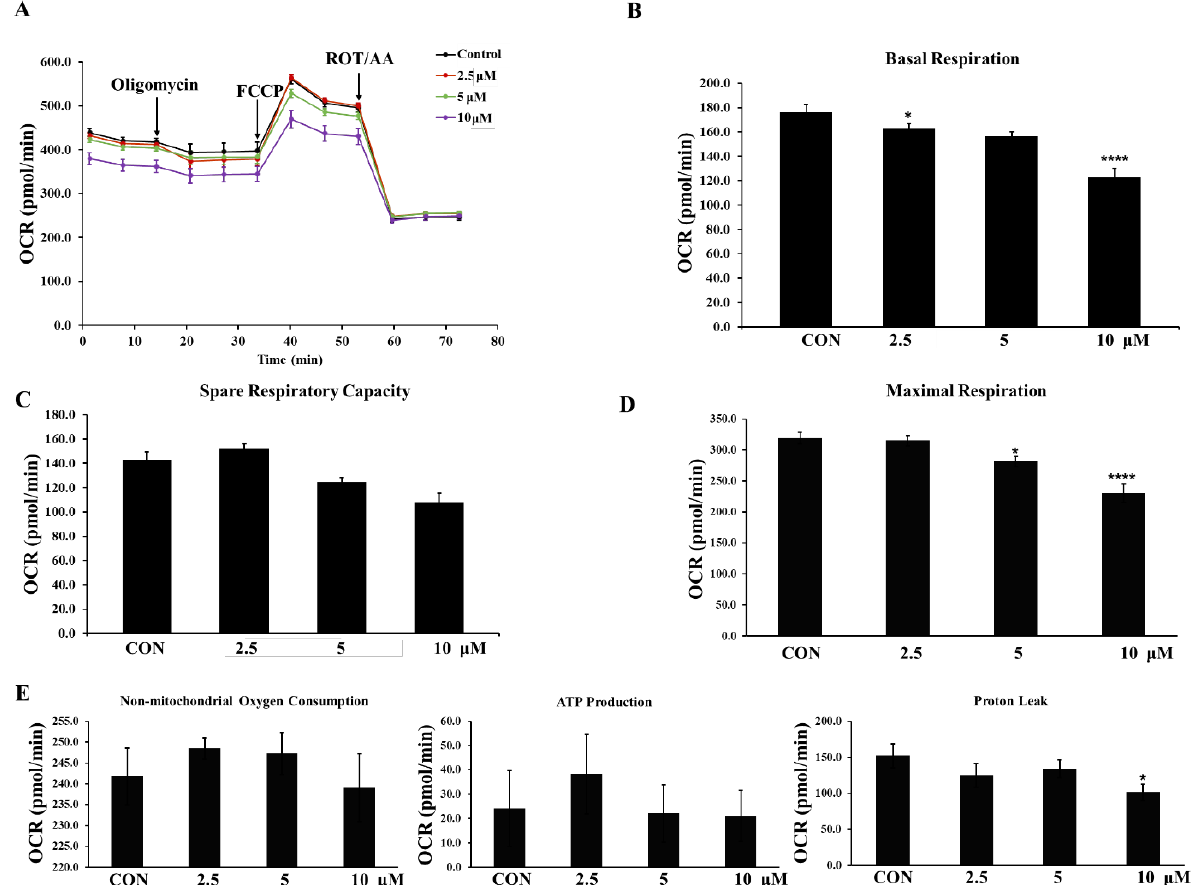
Figure 9. PKM2 specific inhibitor, compound 3h , impairs the mitochondrial activity in LNCaP cells, leading to decreased basal respiration, spare respiratory capacity, and maximal respiration. ( A ) Profile of mito stress test data for oxygen consumption rate (OCR) (pmol/min) in LNCaP cells with arrows indicating injections into media of specific stressors. ( B – E ) Results of Seahorse XFe cell mito stress test generator report shown for OCR (pmol/min). B is for basal respiration, C is for spare respiration capacity, D is for maximal respiration, E is for non-mitochondrial oxygen consumption, ATP production, and proton leak. The values represent the mean ± SD. * p < 0.05 and **** p <